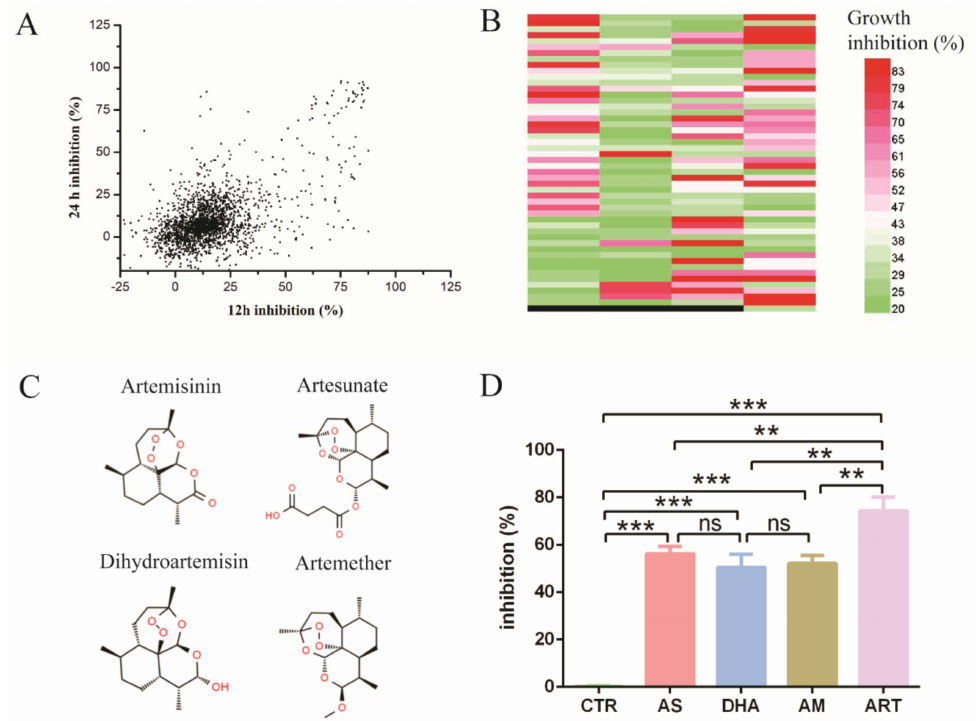
Figure 1. High-throughput screening for new antifungal drugs. ( A ) The inhibition rate of Selleck’s FDA-approved drugs effect on C. glabrata ATCC 2001. X -axis means inhibition rate measured at 12 h, Y -axis means inhibition rate measured at 24 h. The concentration of drugs was 10 µ M. ( B ) Drugs had antifungal activity both at 12 h and 24 h, as confirmed by three independent experiments. Different colors mean different levels of inhibition rate; black means empty (no drug). Each band denotes an individual drug; total number of drugs was 197. ( C ) Chemical structure of artemisinin and derivatives, including artemisinin, dihydroartemisinin, artesunate and artemether. ( D ) The inhibition rate of artemisinin and derivatives: artemisinin had the most obvious effect on the growth of C. glabrata. CTR: control, AS: artesunate, DHA: dihydroartemisinin, AM: artemether, ART: artemisinin. Data are mean ± SD of three independent experiments. The data were analyzed by GraphPad Prism.